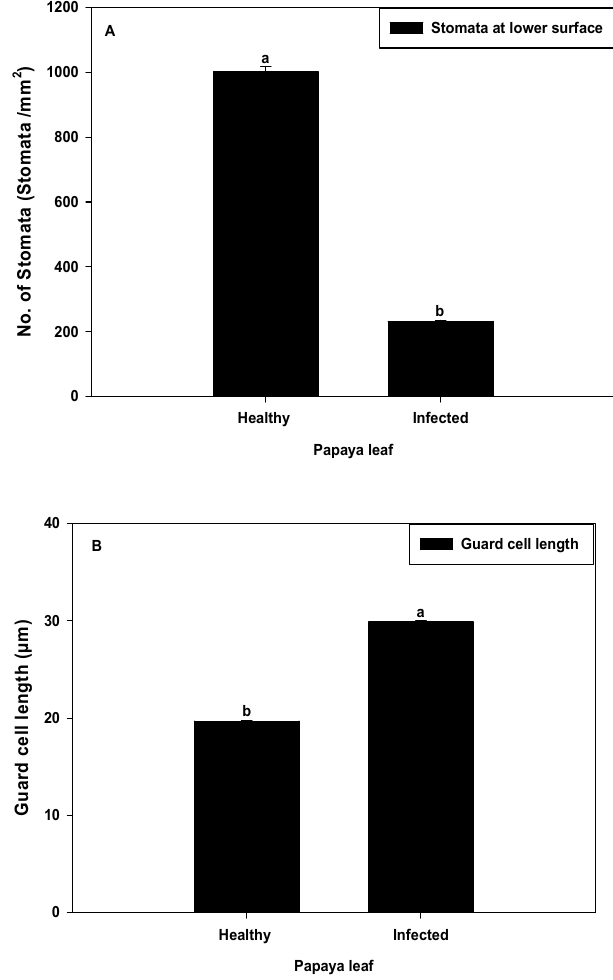
Figure 3. ( A ) Comparative analysis of stomatal density of healthy and infected papaya leaf. ( B ) Comparison of guard cell length of healthy and infected papaya leaf. Error bars shown as the standard error of mean (SE) was computed by Sigma Plot 14, different letters above the error bars show significant differences at p ≤ 0.05.